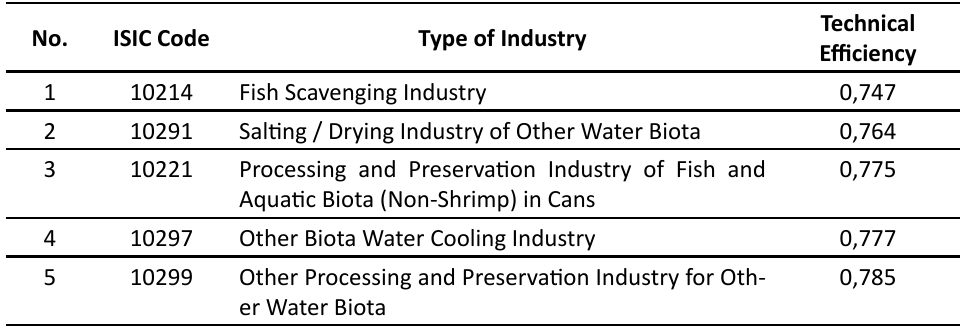
Table 1: The Lowest Industrial Technical Efficiency Level in East Java,